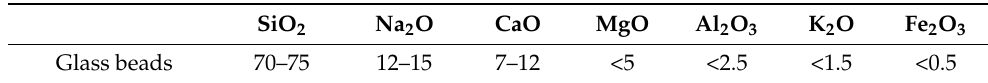
Table 4. Chemical composition of the glass beads (wt.